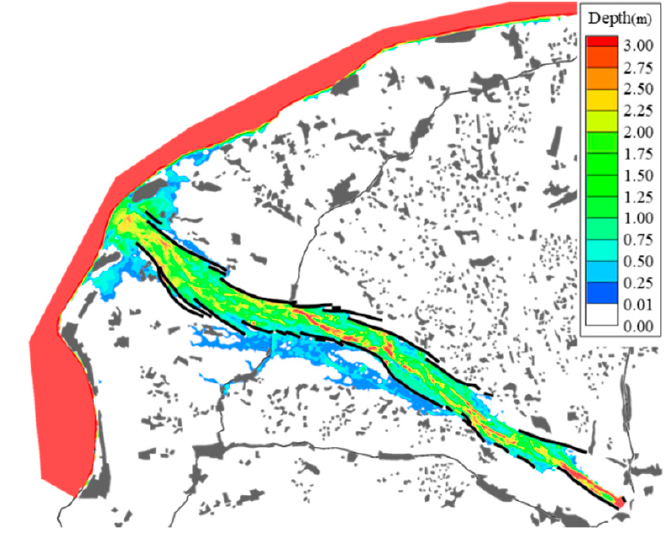
Figure 14. Inundation depth distribution Case (d): elapsed time = 41 h.